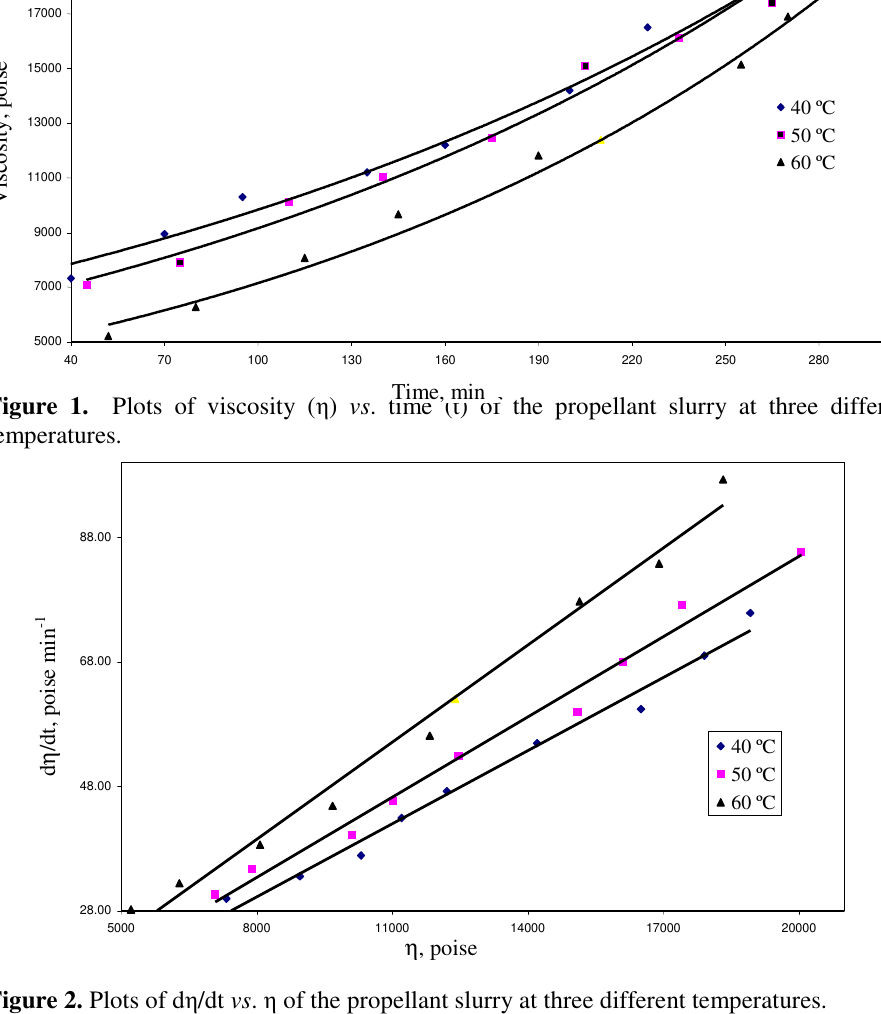
Figure 2. Plots of d η /dt vs . η of the propellant slurry at three different